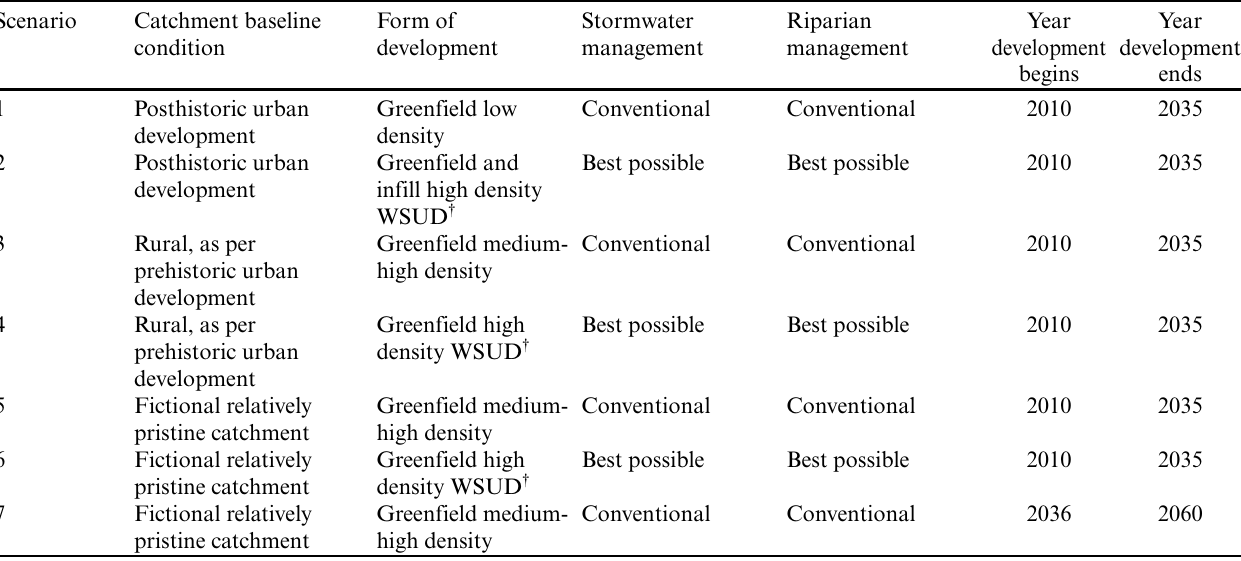
Table 4 . Characteristics of urban development scenarios, Lucas Creek catchment.